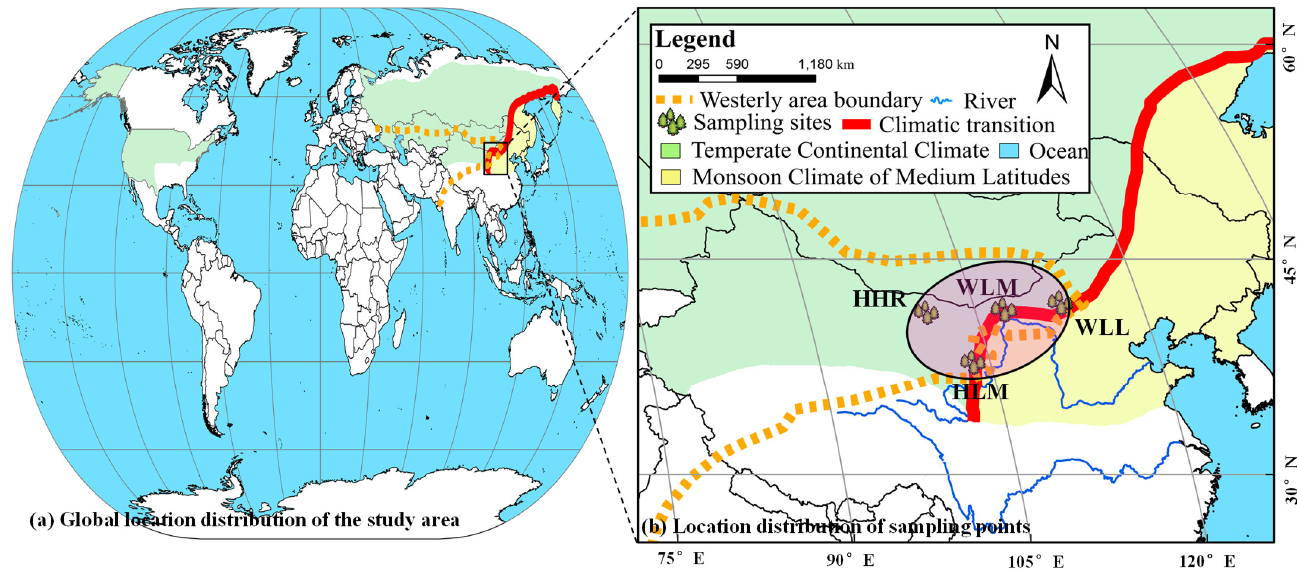
Figure 1. Climate and the distribution of sampling points in the study area.